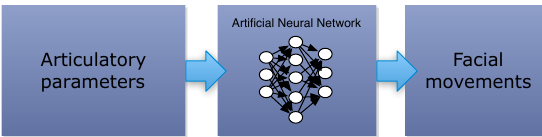
Figure 10. Articulatory to facial movements